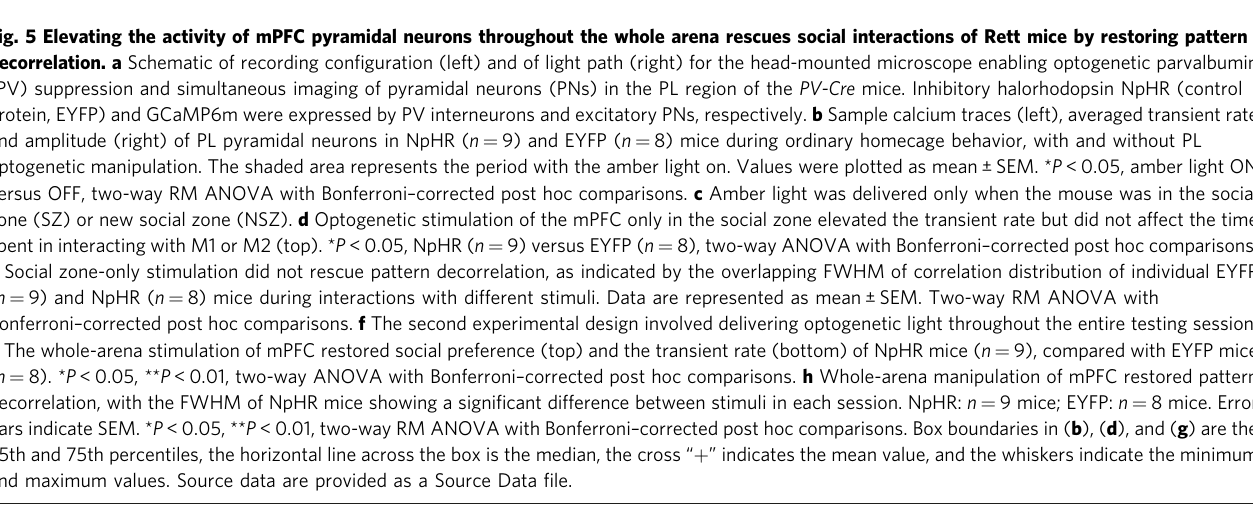
Fig. 5 Elevating the activity of mPFC pyramidal neurons throughout the whole arena rescues social interactions of Rett mice by restoring pattern decorrelation. a Schematic of recording con fi guration (left) and of light path (right) for the head-mounted microscope enabling optogenetic parvalbumin (PV) suppression and simultaneous imaging of pyramidal neurons (PNs) in the PL region of the PV-Cre mice. Inhibitory halorhodopsin NpHR (control protein, EYFP) and GCaMP6m were expressed by PV interneurons and excitatory PNs, respectively. b Sample calcium traces (left), averaged transient rate and amplitude (right) of PL pyramidal neurons in NpHR ( n = 9) and EYFP ( n = 8) mice during ordinary homecage behavior, with and without PL optogenetic manipulation. The shaded area represents the period with the amber light on. Values were plotted as mean ± SEM. * P < 0.05, amber light ON versus OFF, two-way RM ANOVA with Bonferroni – corrected post hoc comparisons. c Amber light was delivered only when the mouse was in the social zone (SZ) or new social zone (NSZ). d Optogenetic stimulation of the mPFC only in the social zone elevated the transient rate but did not affect the time spent in interacting with M1 or M2 (top). * P < 0.05, NpHR ( n = 9) versus EYFP ( n = 8), two-way ANOVA with Bonferroni – corrected post hoc comparisons. e Social zone-only stimulation did not rescue pattern decorrelation, as indicated by the overlapping FWHM of correlation distribution of individual EYFP ( n = 9) and NpHR ( n = 8) mice during interactions with different stimuli. Data are represented as mean ± SEM. Two-way RM ANOVA with Bonferroni – corrected post hoc comparisons. f The second experimental design involved delivering optogenetic light throughout the entire testing session. g The whole-arena stimulation of mPFC restored social preference (top) and the transient rate (bottom) of NpHR mice ( n = 9), compared with EYFP mice ( n = 8). * P < 0.05, ** P < 0.01, two-way ANOVA with Bonferroni – corrected post hoc comparisons. h Whole-arena manipulation of mPFC restored pattern decorrelation, with the FWHM of NpHR mice showing a signi fi cant difference between stimuli in each session. NpHR: n = 9 mice; EYFP: n = 8 mice. Error bars indicate SEM. * P < 0.05, ** P < 0.01, two-way RM ANOVA with Bonferroni – corrected post hoc comparisons. Box boundaries in ( b ), ( d ), and ( g ) are the 25th and 75th percentiles, the horizontal line across the box is the median, the cross “ + ” indicates the mean value, and the whiskers indicate the minimum and maximum values. Source data are provided as a Source Data fi